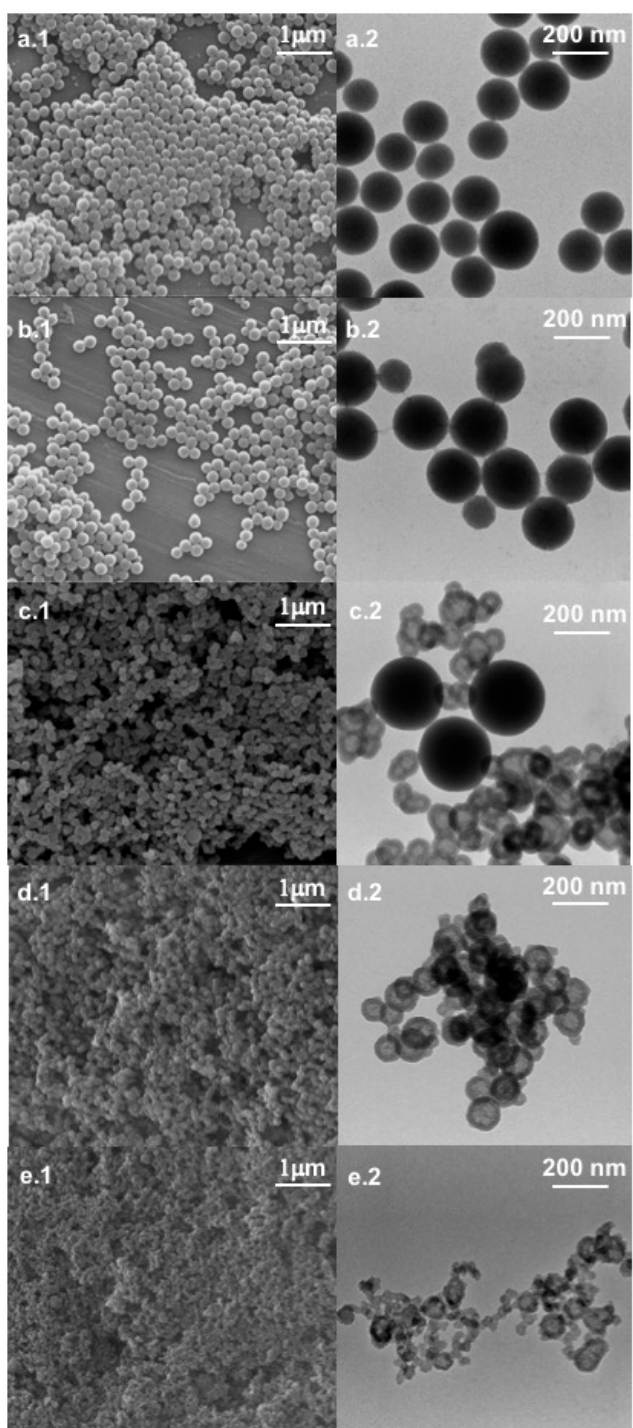
Figure 1. From top to bottom: SEM (left column) and TEM (right column) micrographs of bare silica